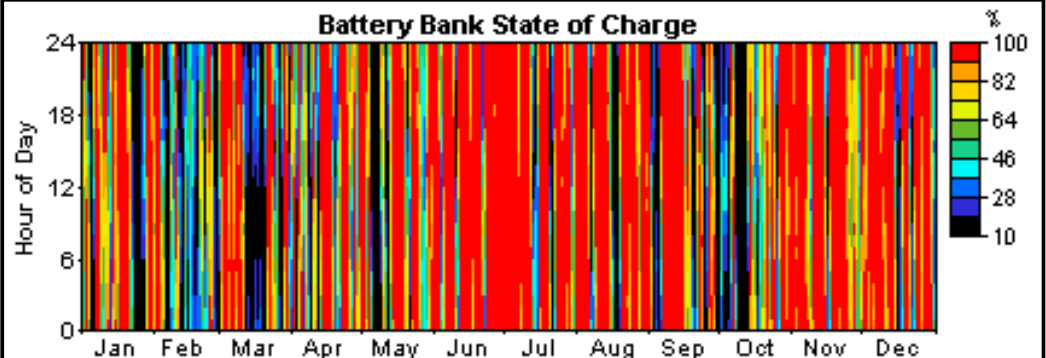
Figure 8. Vanadium Redox Battery (VRB) state of charge variations over a twelve month period.